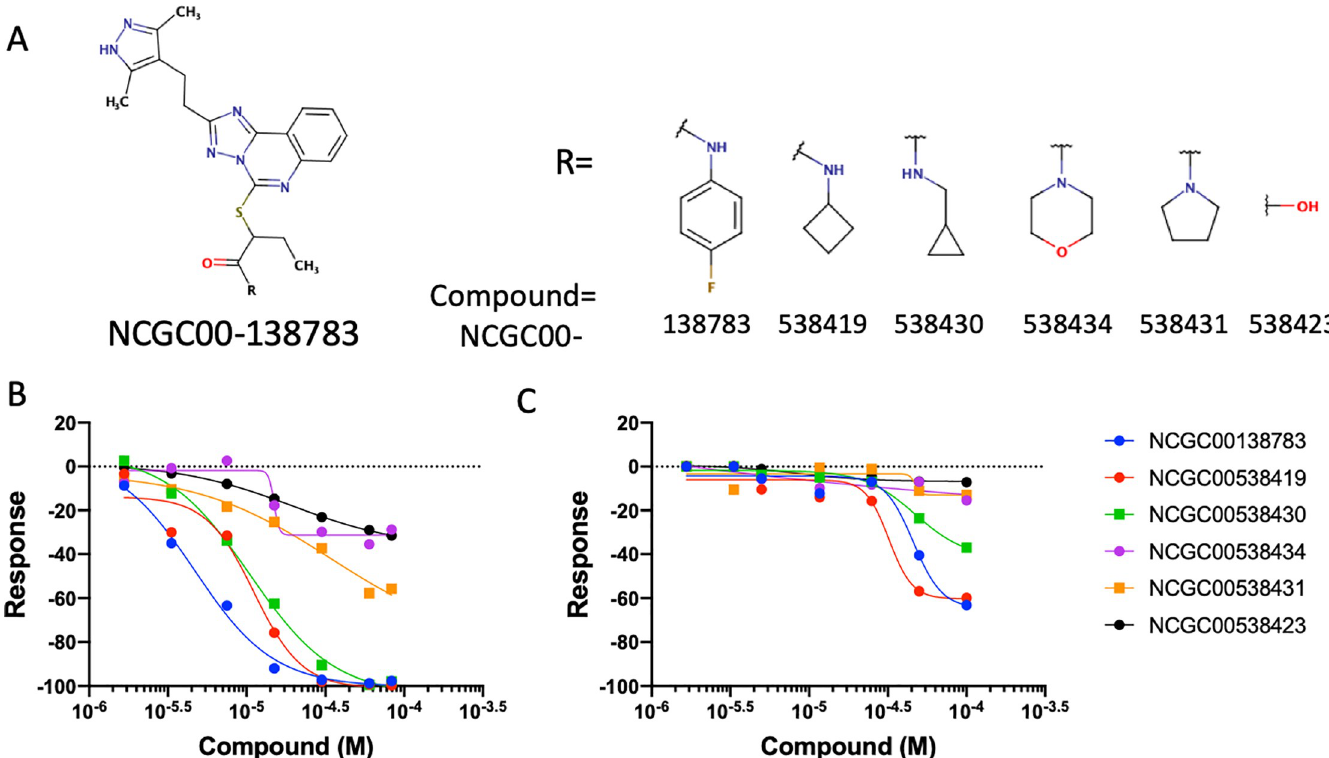
Fig 6. Comparing small molecule activity profiles using the LSC assay and the biochemical assay. (A) The structures of the compounds compared to the parent screening active compound (NCGC00138783). (B) Biochemical (ALPHAScreen) SIRP α -CD47 antagonism activity of NCGC00138783 and the structurally related analogs shown in A were compared to (C) antagonism activity of SIRP α binding to CD47 expressed on live Jurkat cells in the LSC assay. Normalized activity calculated with neutral control (CD47 + SIRP α , no inhibitor) as 0% and negative control (CD47—SIRP α , no inhibitor) as -100% activity. Assay activity with tested agents was then compared and normalized to these